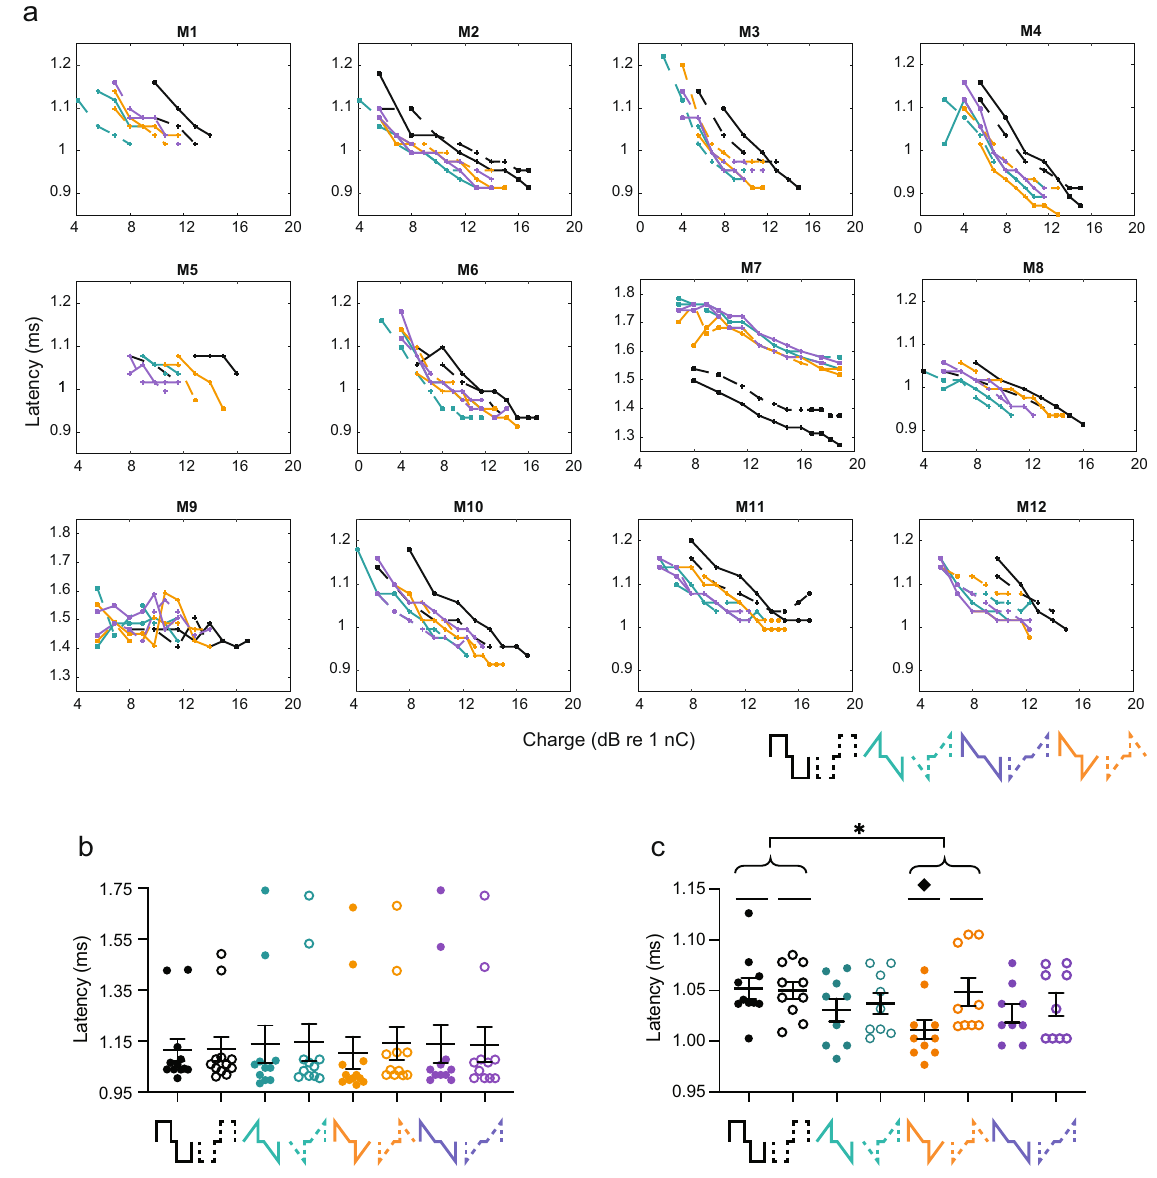
Figure 3. rampDOWN have shorter wave II latency than Rec. ( a ) Individual wave II latencies as a function of charge. Mouse (M)1–12. Pulse shapes are indicated by color and shown in the legend (bottom right). Solid line, anodic-first; dashed, cathodic-first. Note the longer latency with M7 and M9. ( b ) Wave II latency at three dB above threshold. ( c ) Wave II latency at three dB above threshold with M7 and M9 excluded. Pulse shapes are drawn on the x-axis. Each circle is data from one mouse. Closed circles, anodic-first pulses; open circles, cathodic-first pulses. Asterisk and diamond denote significant effect in post-hoc test of the factor pulse shape and the pulse shape * polarity interaction (Tukey HSD), respectively. * p ≤ 0.05; ♦ p ≤ 0.05. n = 12. Error bars are